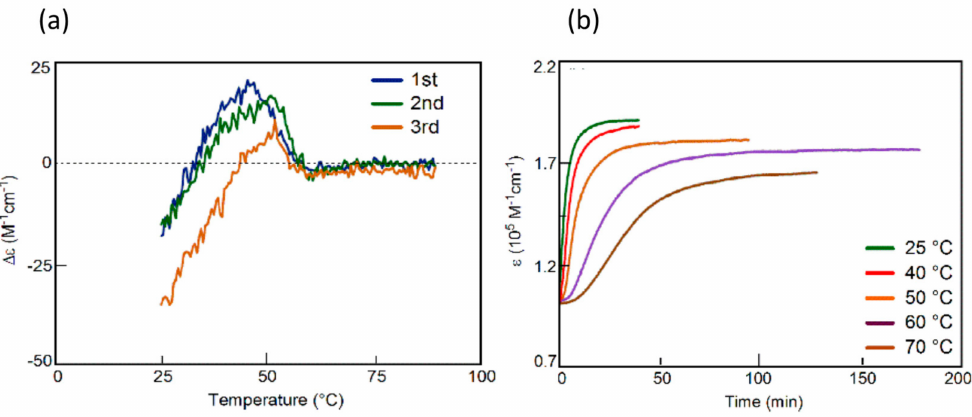
Figure 26. Kinetics in chiral symmetry breaking during hetero-double-helix and self-assembly gel formation shown by ∆ ε /time profiles from repeated experiments ( a ) and ε /time profiles at different temperatures ( b ). Reproduced from reference 79 by permission from John Wiley &